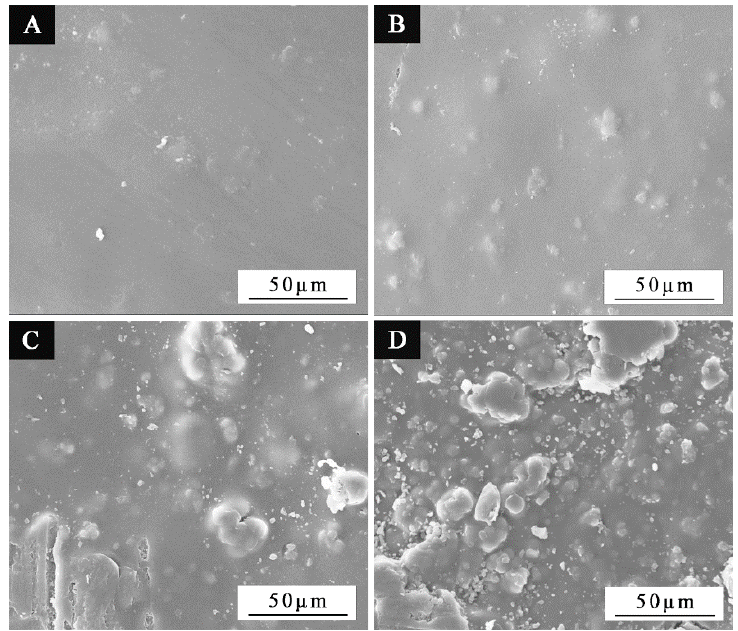
Figure 5. SEM of paint film with different concentrations of microcapsules (core-shell ratio = 0.58:1): ( A ) 0, ( B ) 5.0%, ( C ) 10.0%, ( D ) 25.0%.